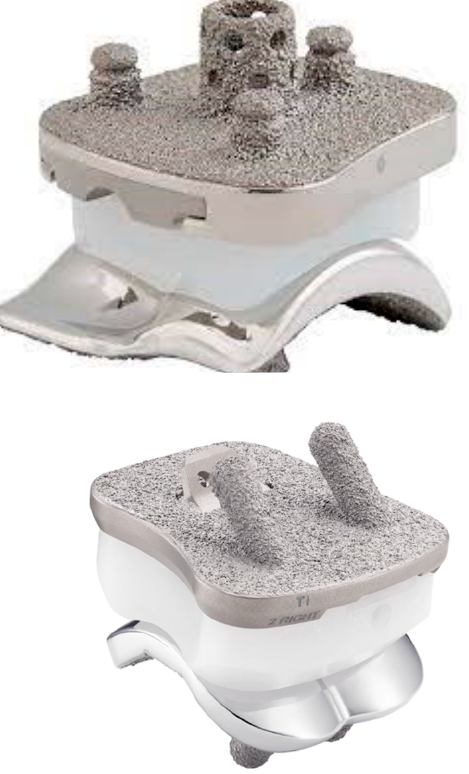
Figure 7. The Vantage TAR is shown on the left and the Cadence TAR is shown on the